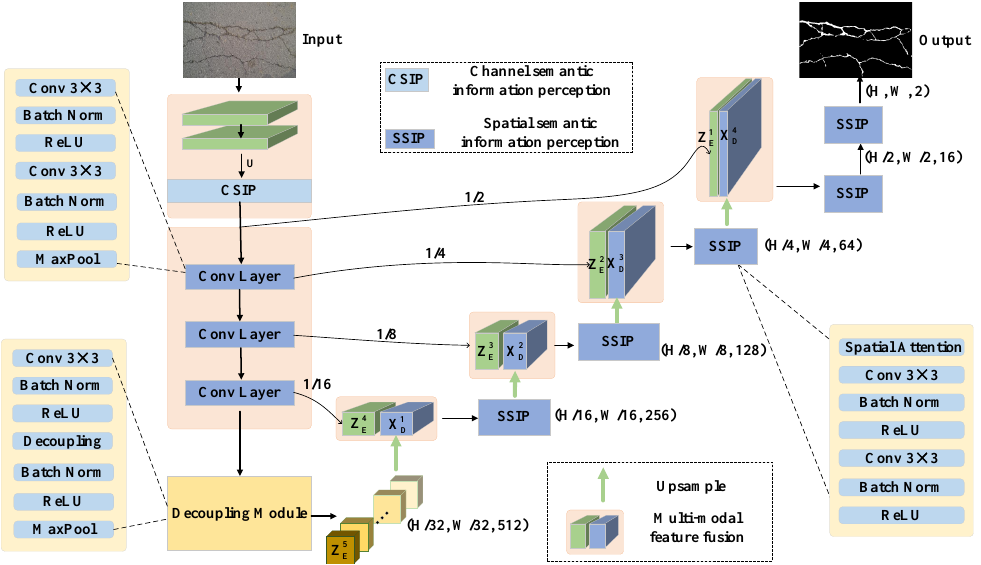
Figure 1. The structure of the proposed network for crack